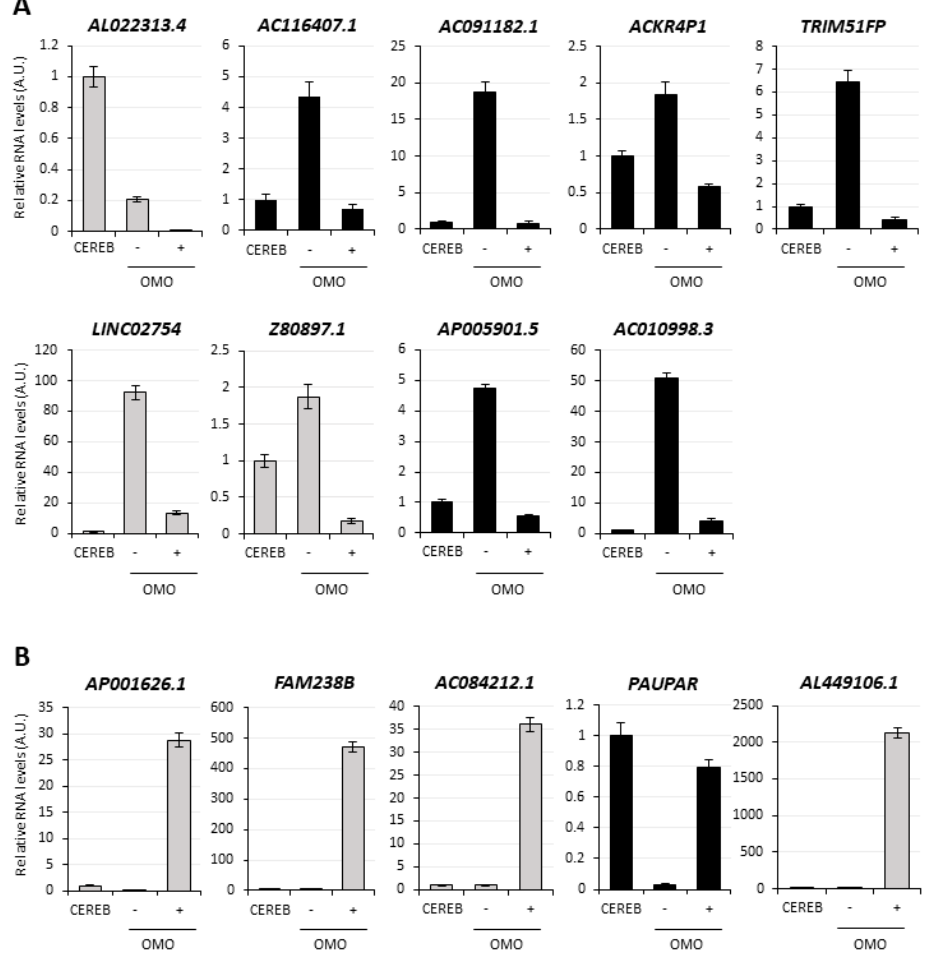
Figure 5. MYC-regulated lncRNA profiling in healthy cerebellum RNA samples. ( A ) Comparison of the expression profile, by qRT-PCR, of the 9 lncRNAs downregulated in D283-OMO cells 72 h-treated with DOX (OMO+) compared to healthy cerebellum RNA samples (CEREB set as 1). As control, the analysis in untreated D283-OMO cells (OMO − ) was also carried out. Data (means ± SEM from technical replicates) are expressed in arbitrary units (A.U.) and are relative to ATP5O mRNA levels. N = 1. ( B ) qRT-PCR analysis in healthy cerebellum RNA samples (CEREB, set as 1) of the 5 lncRNAs upregulated in D283-OMO cells upon OMOMYC induction (see Figure 4). Details as in panel ( A ).